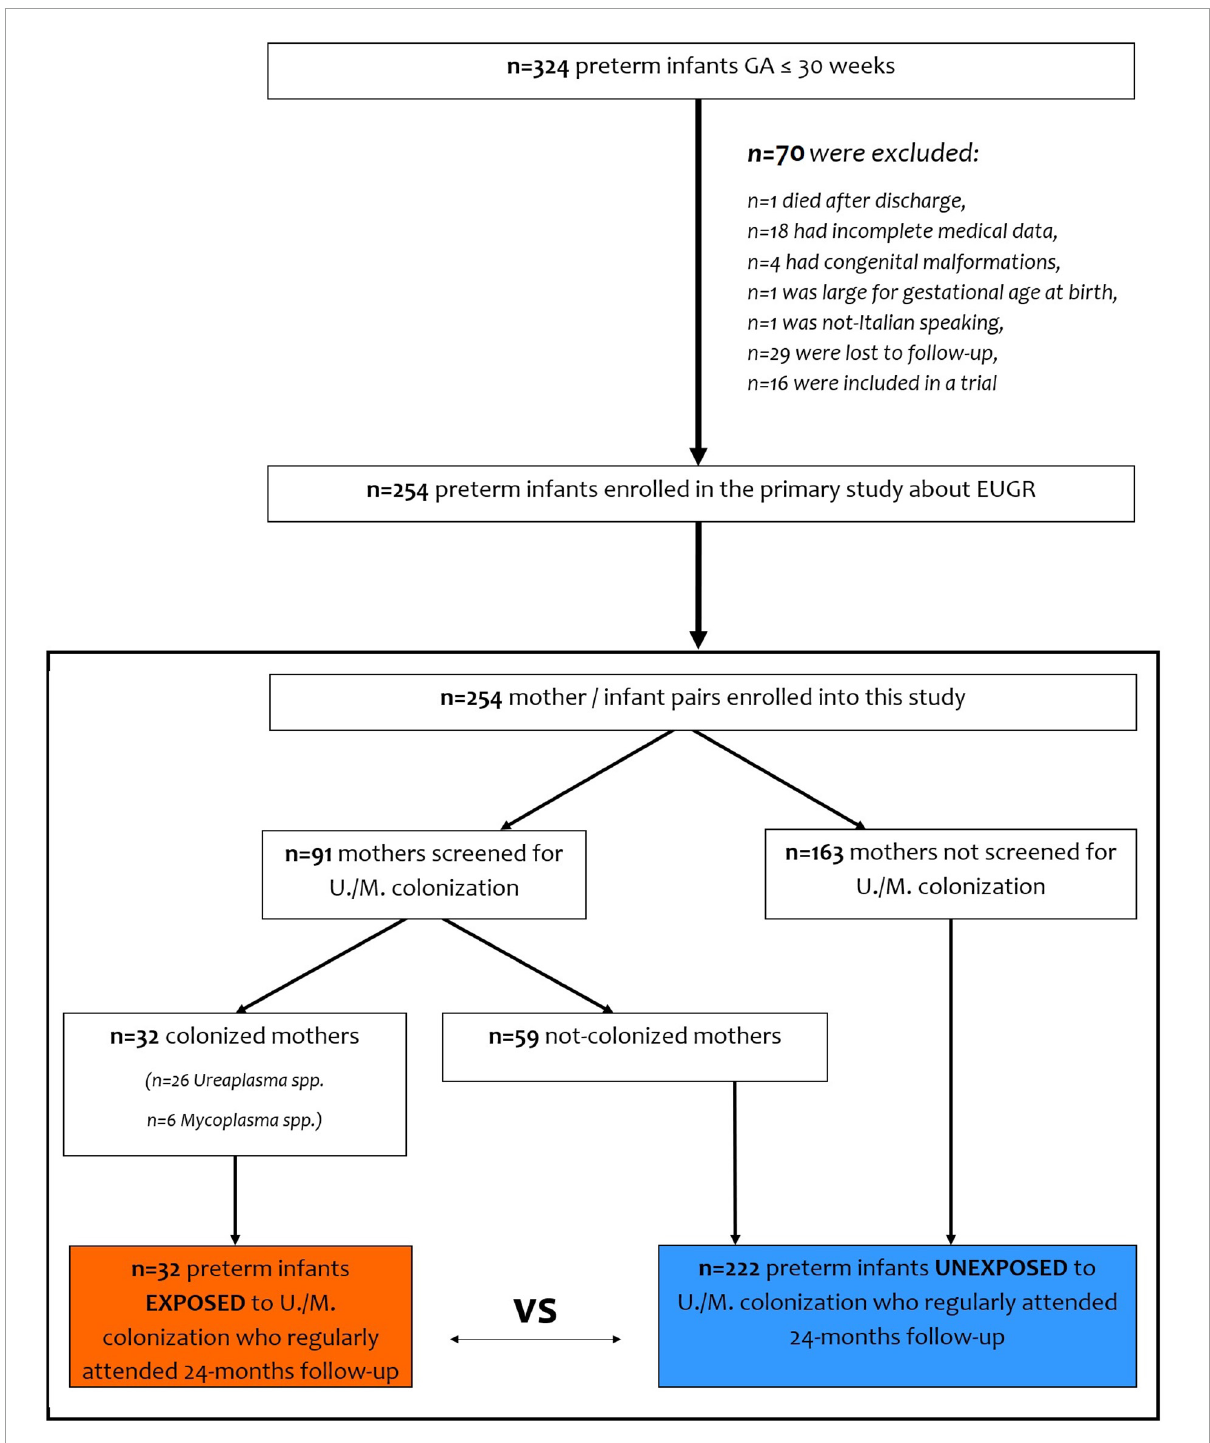
FIGURE1 Flow-chart of the study design.